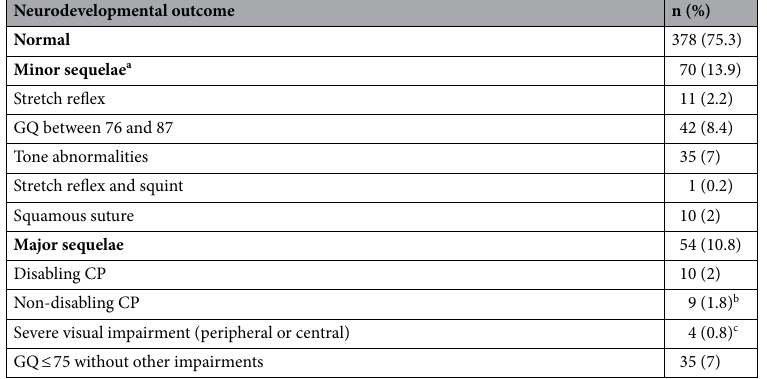
Table 2. Neurodevelopmental outcome of the total study population (n = 502) at 24 months of CA. GQ general quotient, CP cerebral palsy. a Each child can present more than one minor sequel. b 7 children had GQ > 75. c 3 children had CP and one had GQ < 75.